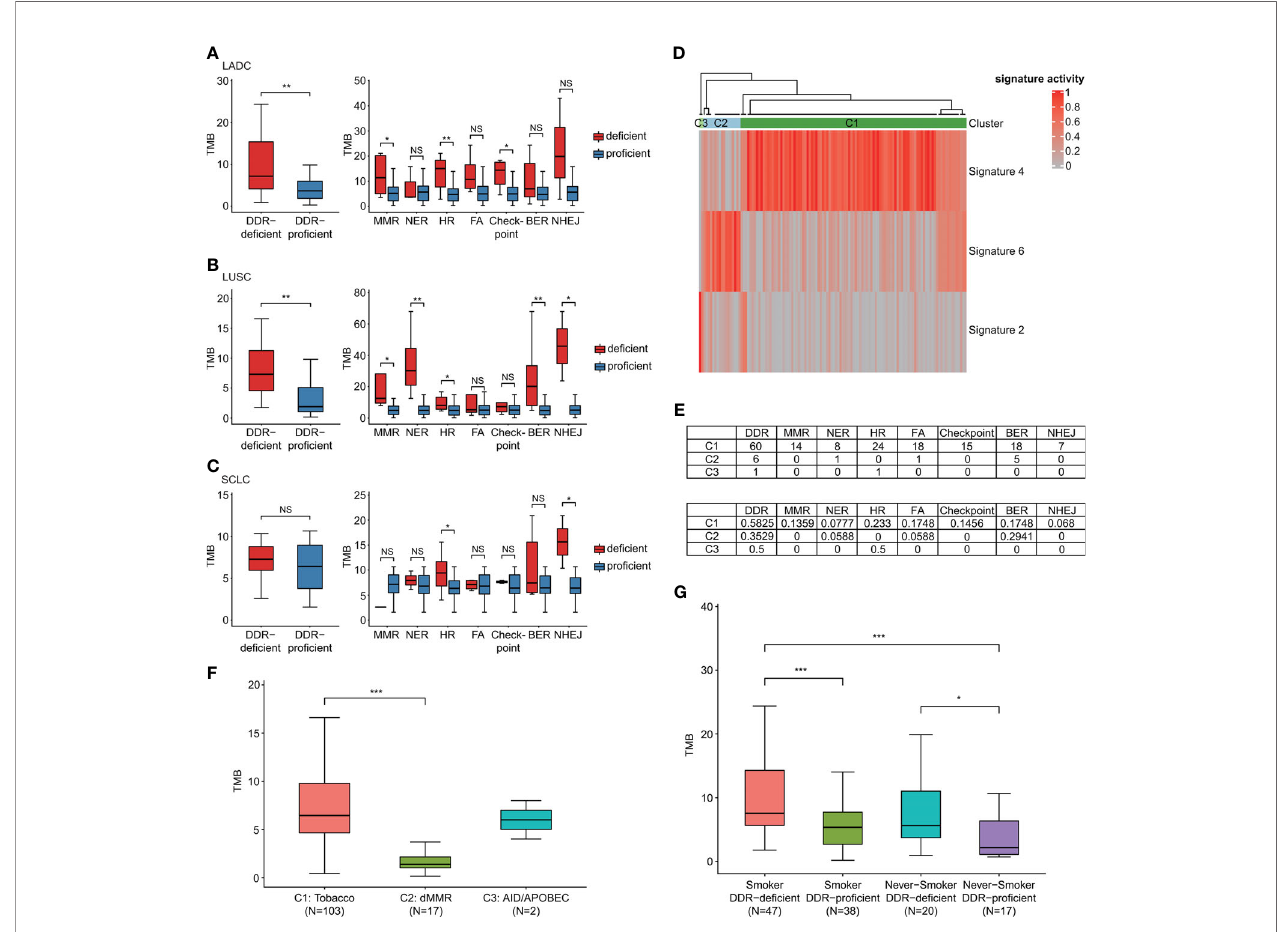
FIGURE 2 | DDR-altered malignancies contained increased mutational load. (A) The effect of DDR gene alterations on LADC patients ’ TMB levels (own dataset, n = 42). (B) The effect of DDR gene alterations on LUSC patients ’ TMB levels (own dataset, n = 37). (C) The effect of DDR gene alterations on SCLC patients ’ TMB levels (own dataset, n = 36). When comparing the TMB status of groups with DDR gene alterations to those harboring no DDR-related genomic mutations, TMB was comparably higher in LADC and LUSC participants with DDR genomic alteration than DDR-pro fi cient patients. SCLC also showed a similar trend although no signi fi cant difference was observed. (D) Three mutational signatures (signature 2, 4, and 6) and three subgroups (C1 – C3) via unsupervised clustering analysis. (E) The mutation number and proportion of different pathways in different molecular subgroups. (F) TMB distribution of different molecular subgroups C1 – C3. Samples most relevant to signature 6 (dMMR) failed to show relatively high TMB. (G) Effects of DDR gene mutations and smoking on TMB. Wilcoxon rank-sum test was utilized to study the relationship of DDR gene alterations with TMB. * p < 0.05, ** p < 0.01, and *** p < 0.001. The “ checkpoint ” referred to “ cell cycle checkpoint ” . The "NS" referred to "not signi fi